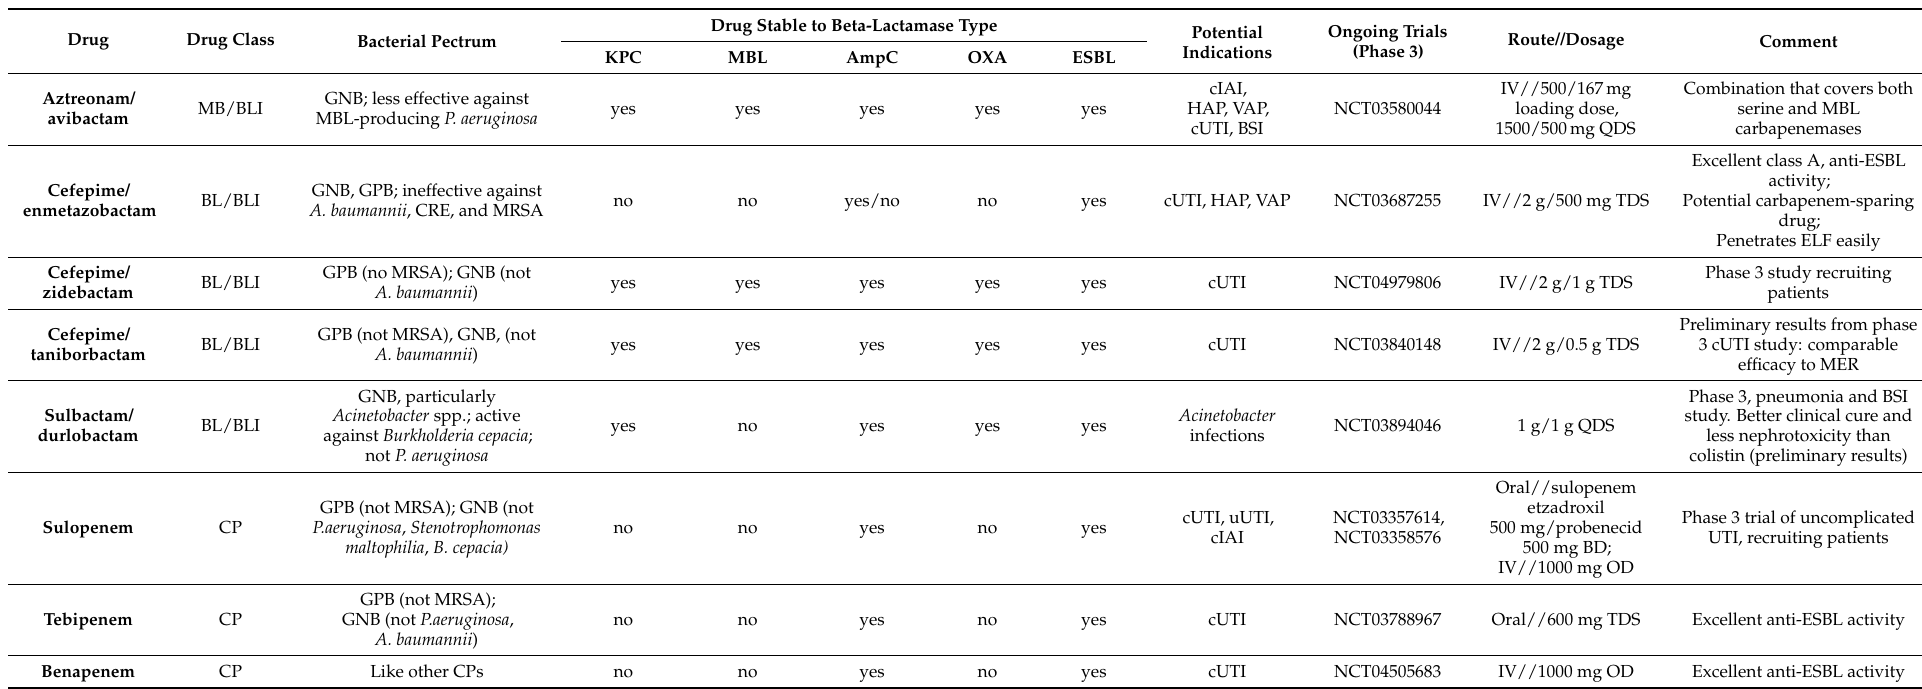
Table 2. Characteristics of novel anti-Gram-negative antimicrobial agents in phase 3 clinical